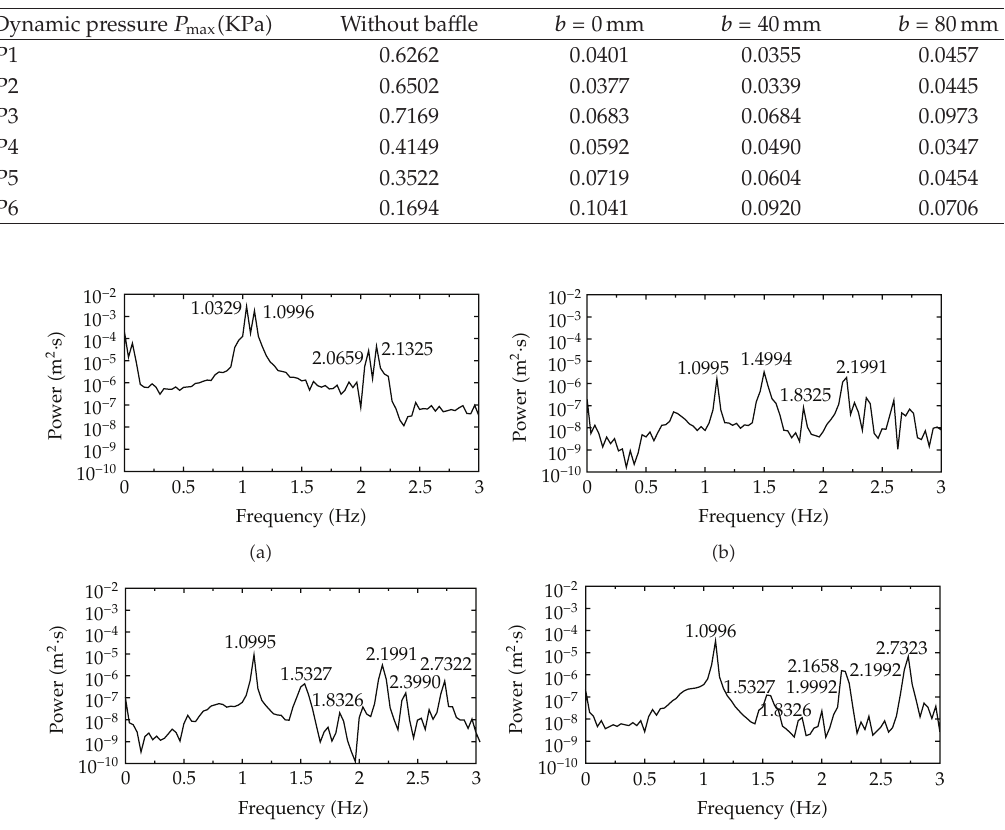
Table 1: The maximum dynamic pressure acting on the tank sidewalls for the di ff erent combinatorial ba ffl es installed inside the tank.